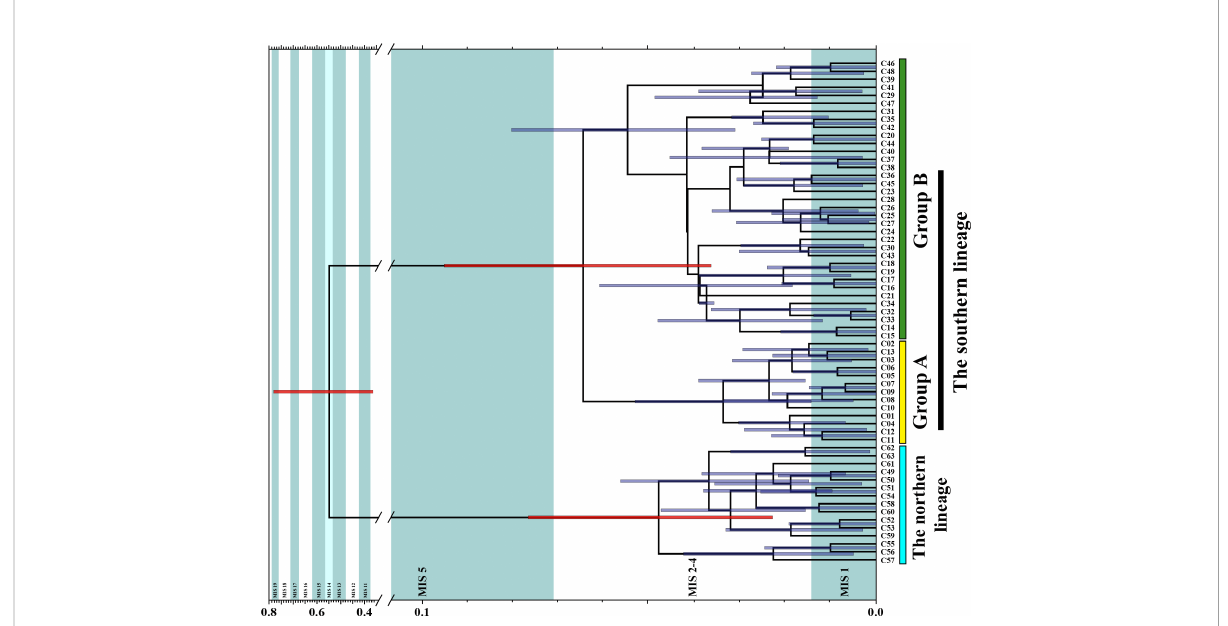
FIGURE 4 Divergence time of the southern and northern lineages based on Yule Process Model and calibrate substitution rate of Cytb . Intervals of marine isotopes stages are annotated following Hao et al. (2015). Interglacial periods in pale green, glacial periods in white, and the warmer glacial period MIS 14 in light blue. Node bars indicate 95% HPD intervals of the divergence times. Three red node bars denote divergence time between the northern and southern lineages, divergence time between groups A and B of the southern lineage, and tMRCA of the northern lineage